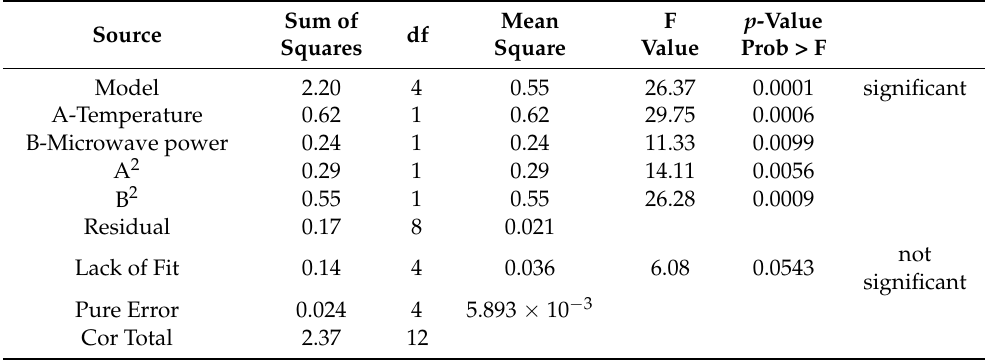
Table 12. Analysis of variance for AC response using